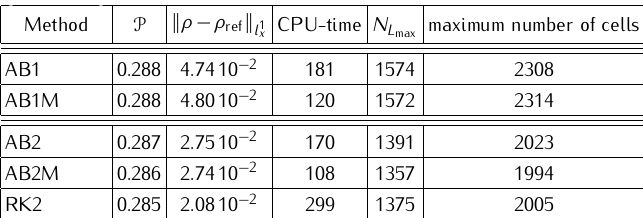
Table 3. Comparison of numerical schemes of the first and second